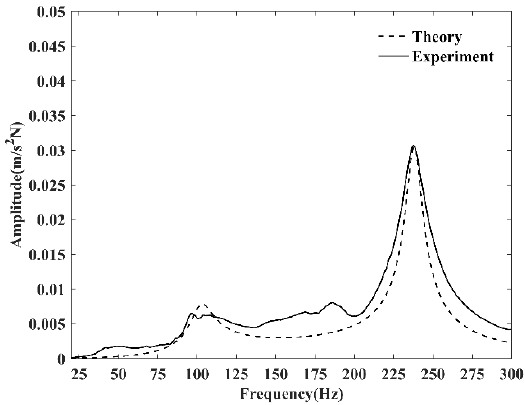
Figure 12. Comparison of theoretical and experimental AFRF of the thrust bearing.